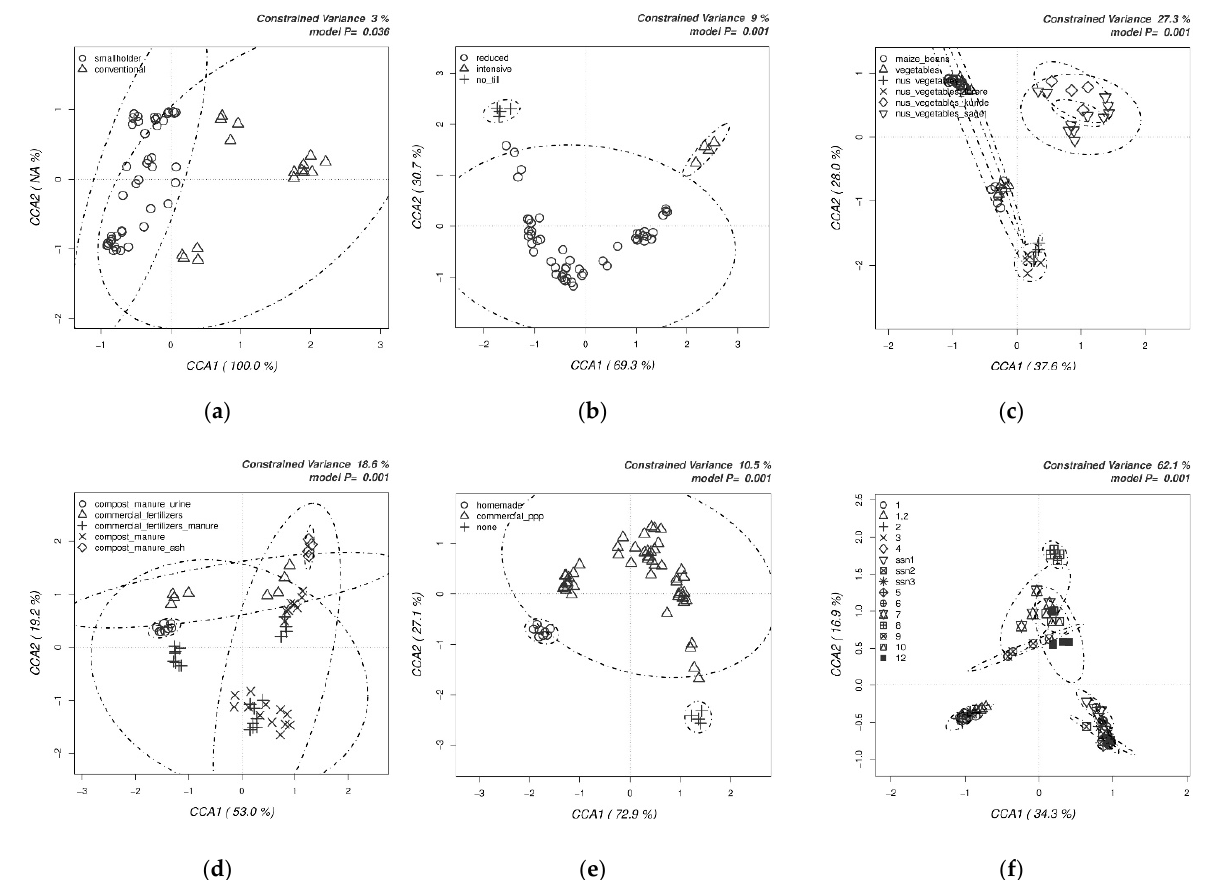
Figure 4. Canonical correspondence analyses (CCAs) on the impact of the farm management choices on the structure of fungal communities. This was determined by the relative abundances of all the OTUs obtained by Illumina sequencing of fungal ITS amplicons.